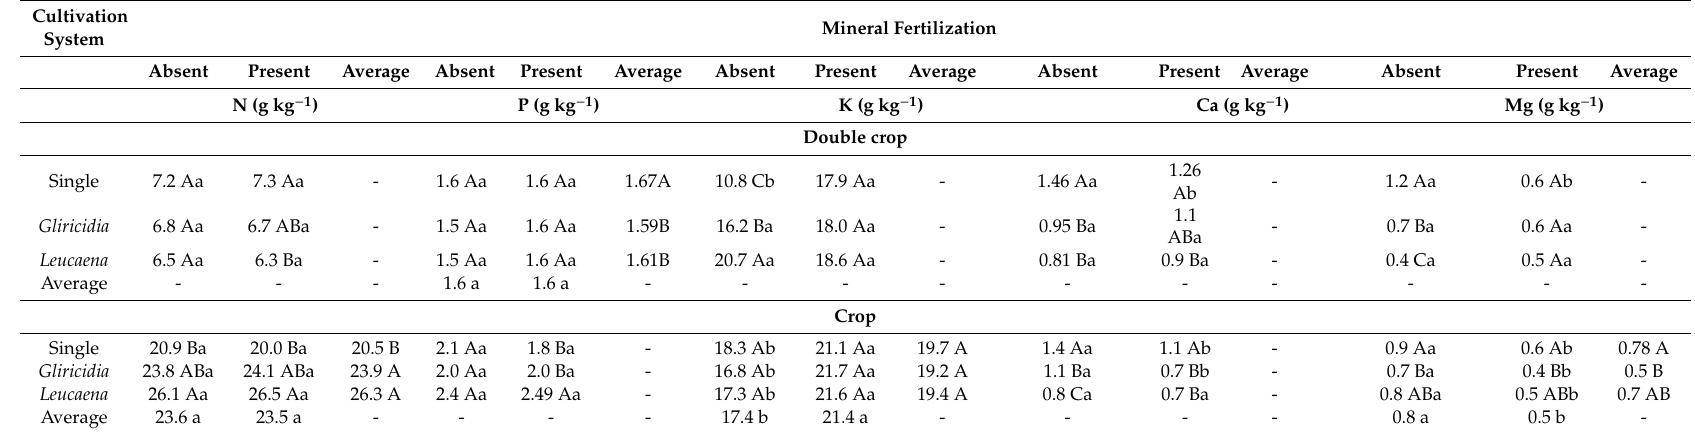
Table 5. Leaf macronutrients contents of forage sorghum cultivated with the combination of alleys and mineral